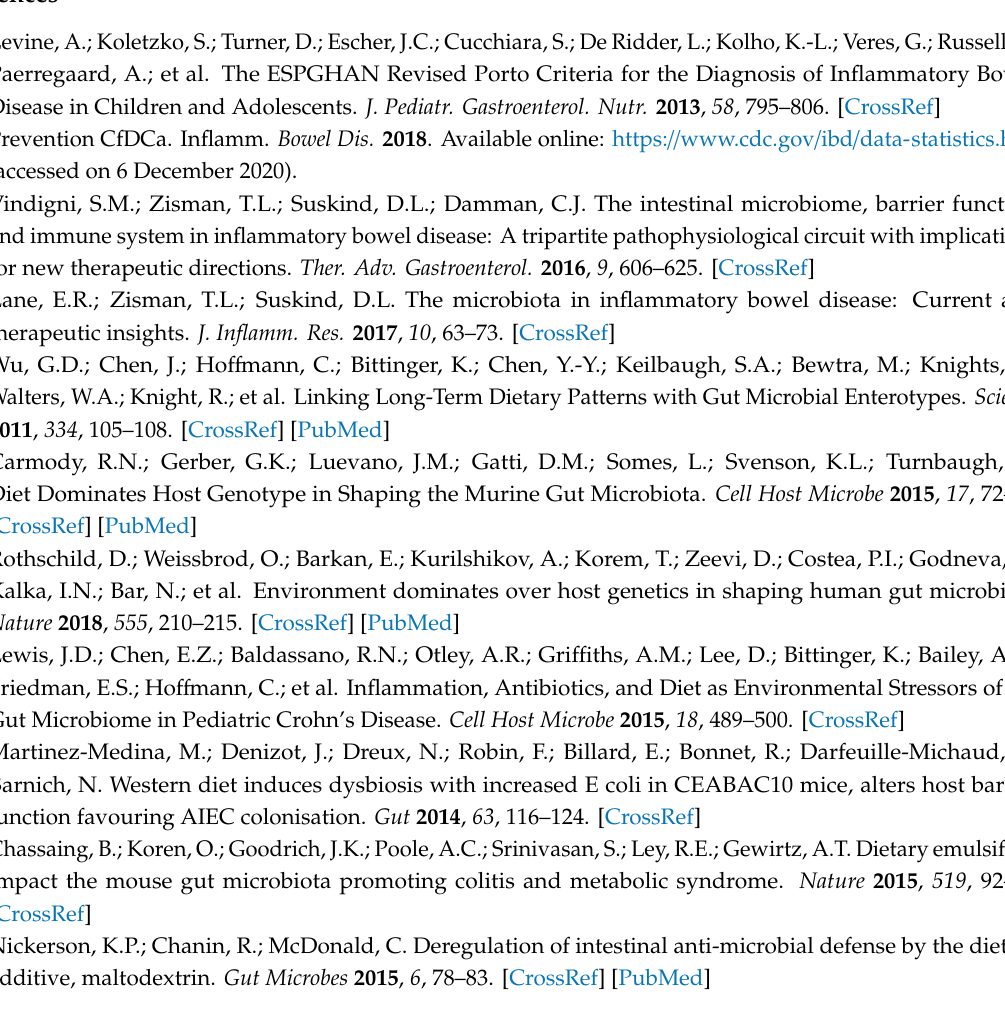
from metabolomics analysis were used in the principal component analysis and their clustering / distribution patterns were shown separately; volatile metabolites (left) and global metabolites (right). The severe